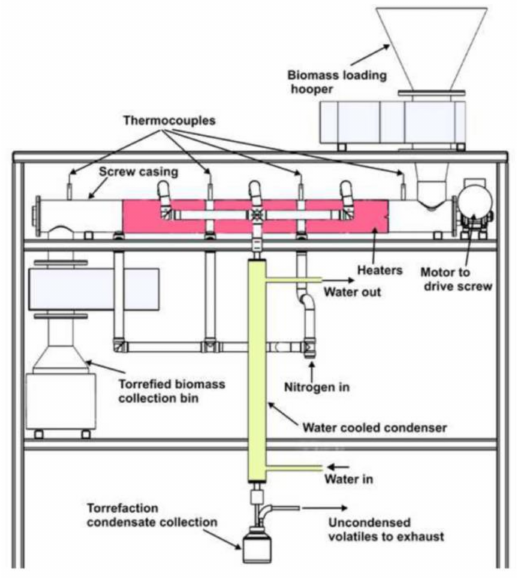
Figure 1. Torrefaction reactor